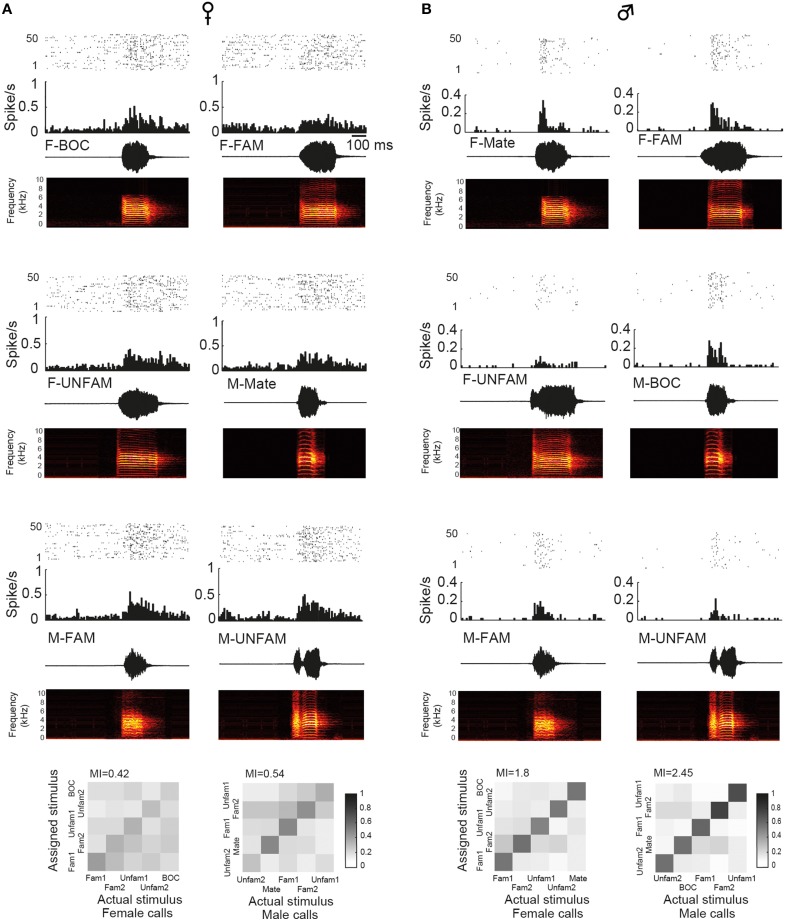
Examples of single-unit responses obtained in a female (A) and in the male paired with this female (B). In each panel are: a raster plot (top 50 iterations), a peristimulus histogram that displays the number of action potentials per bin of 10 ms (middle), and the waveform and spectrogram of the call used as the stimulus (bottom). BOC, bird's own call; F-FAM, call of one familiar female; F-UNFAM, call of one unfamiliar female; MC, mate's call; M-FAM, call of one familiar male; M-UNFAM, call of one unfamiliar male. The calls of two familiar males and females and two unfamiliar males and females were used as auditory stimuli. Neurons have an AF index of 0.012 and 0.131, respectively. Below, “confusion matrices” illustrate the proportion of assignments to the correct stimulus. The grayscale represents the proportion of the 50 responses to the call stimulus indicated on the x-axis that was estimated to be closest to the responses evoked by the call stimulus indicated on the y-axis and assigned to this stimulus. A black diagonal on a white background would indicate the assignment of all spike trains to the correct stimulus.